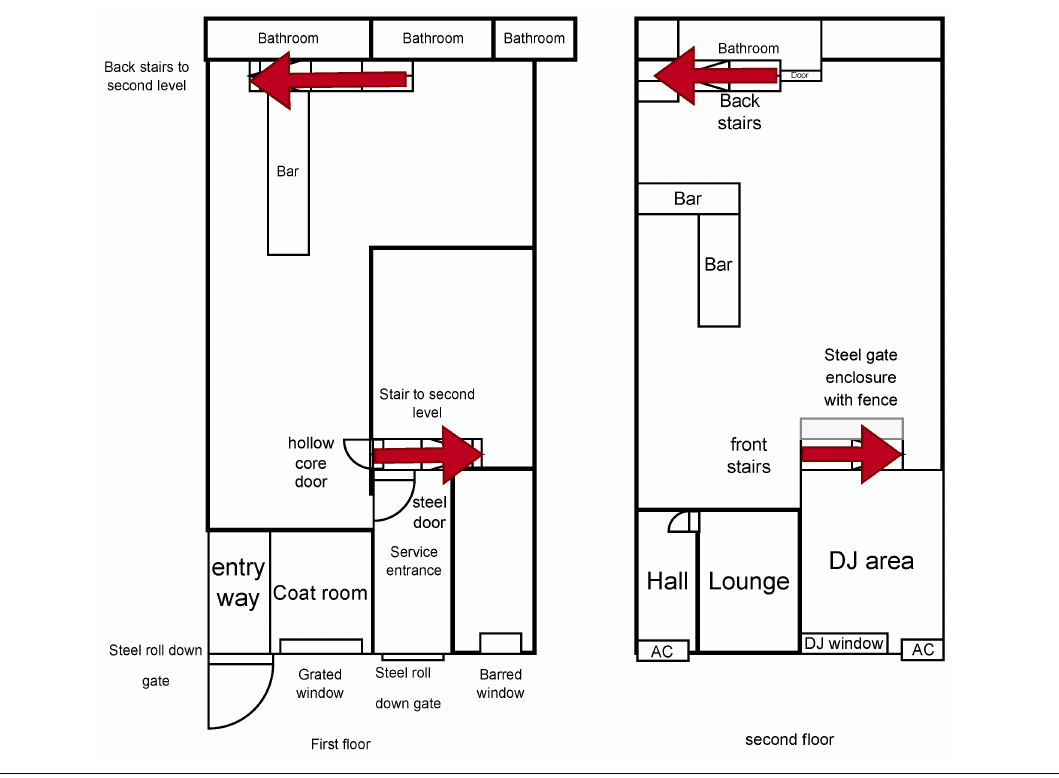
Figure 4. Floorplan of Happy Land Social Club (Source: Susan Brandt, adapted from layout published by the Building and Fire Research Laboratory)